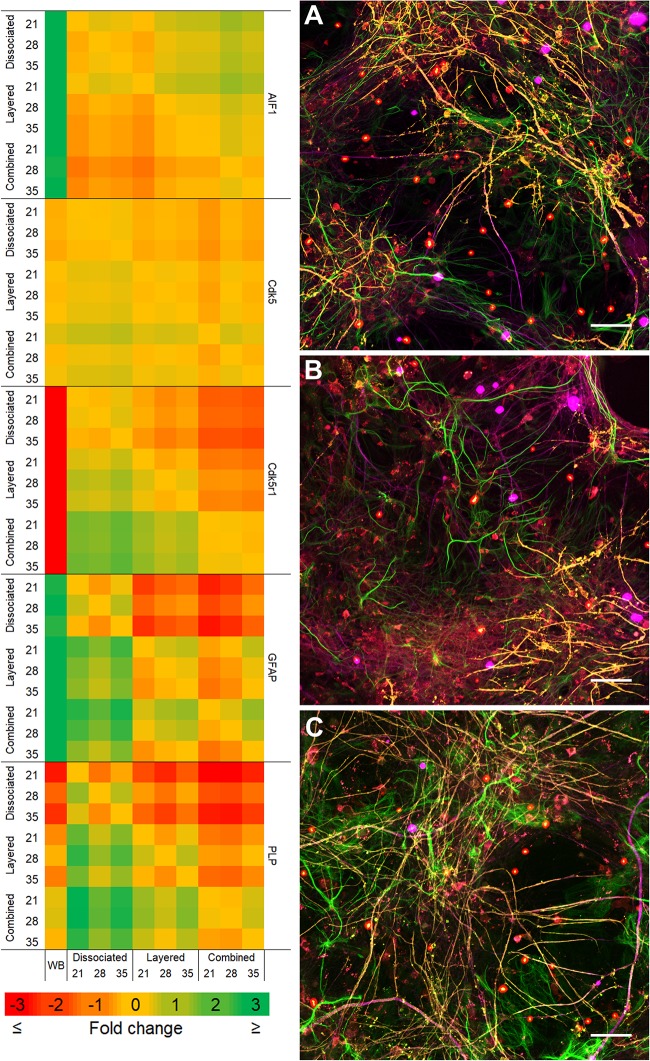
Heat map of qPCR gene expression comparisons between all culture types and whole brain (WB) extract. Maximum intensity projections of composite images of DMMC (A) and co-cultures layered (B) and concurrent (C) at 35 days. Red – Iba1, Green – GFAP, Orange – PLP/DM20 and Magenta – H-NF (n = 3, Scale bar = 50 μm). Large saturated round structures are artifacts and were excluded from analysis.